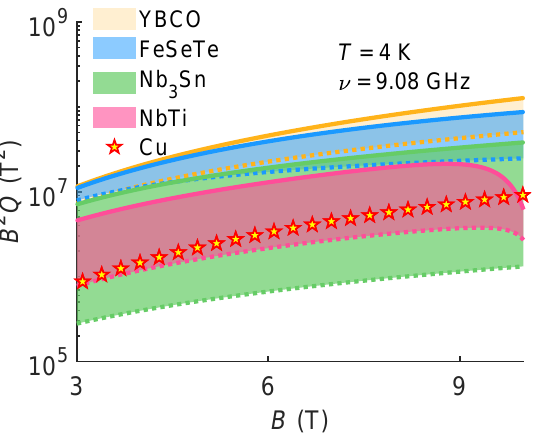
Figure 4. Comparison of the B 2 Q factors evaluated at 4 K and 9.08 GHz as a function of B . The dotted lines represent the worst lower limit obtained in the B ⊥ J configuration. The continuous lines represent a more realistic situation, for which the α angular coefficient is taken into account, as is explained in the text. The ‘star’ symbols represent the B 2 Q values obtained with a Cu cavity, the yellow area represents the values obtainable with YBCO, the light blue area represents those with FeSeTe, the green area represents those with Nb 3 Sn, and the red area represents those with